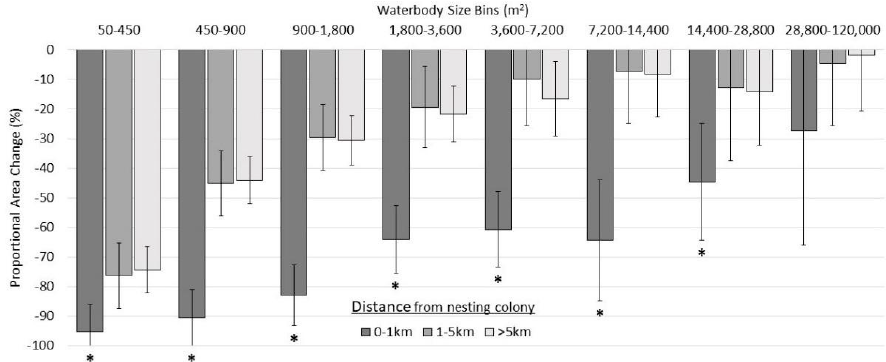
Figure 6. Bar plots showing the proportional area change by distance from the nesting colony and waterbody size intervals. The error bars represent 95% confidence intervals. Asterisks are present when the 0–1 km distance group is significantly different from the other distance groups based on the least-squares means estimates.